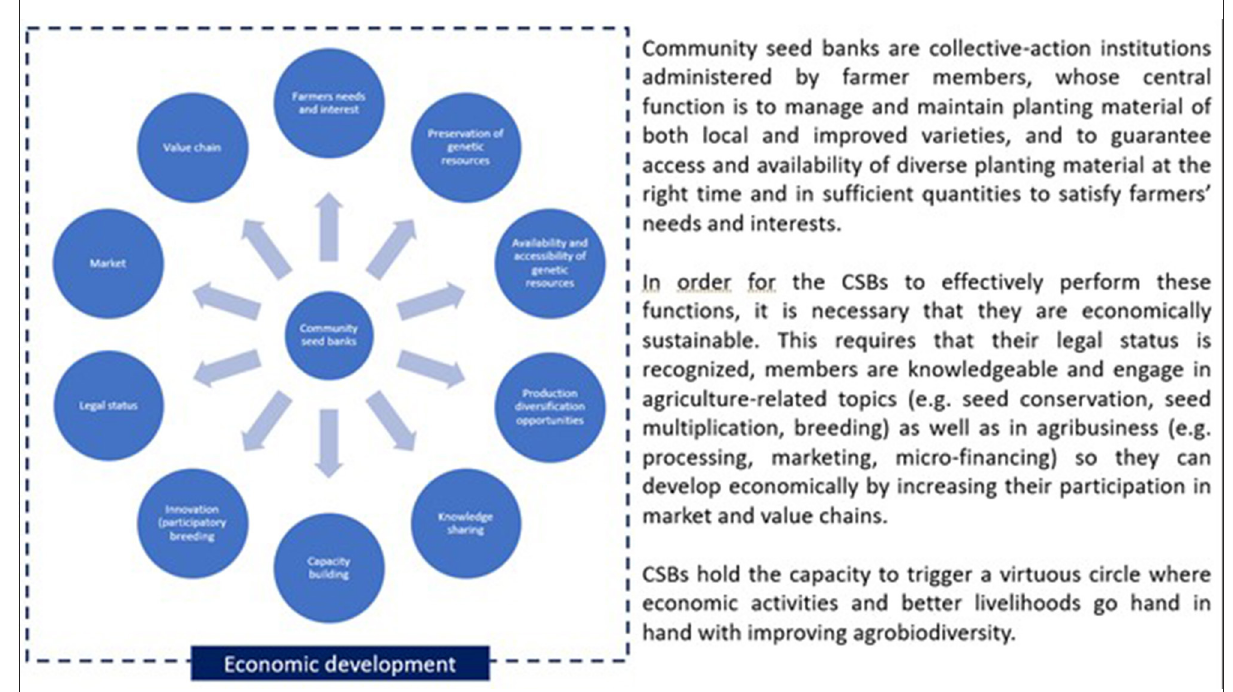
FIGURE1 Conceptual framework illustrating the functions and features of long-term functional community seed